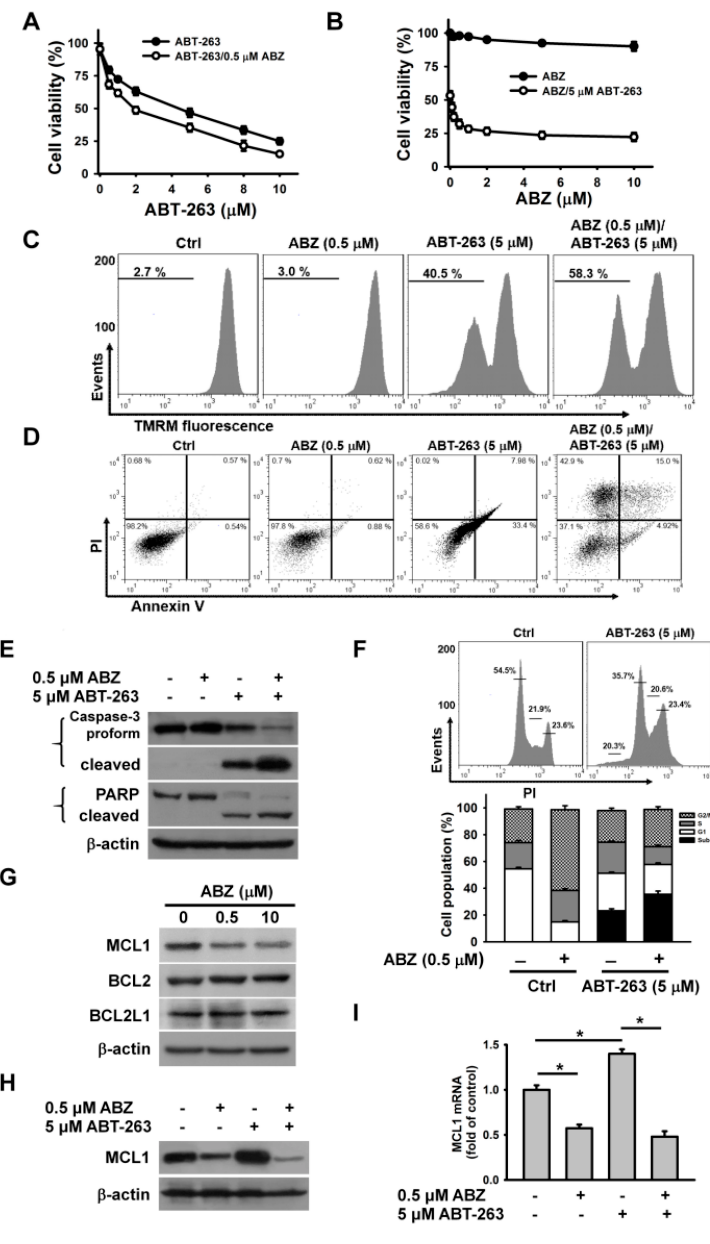
Figure 2. ABT-263 induced apoptosis of ABZ-treated K562 cells. Without specific indication, K562 cells were incubated with 0.5 μ M ABZ, 5 μ M ABT-263, or the combination of 0.5 μ M ABZ and 5 μ M ABT-263 for 24 h. ( A ) ABZ enhanced the cytotoxicity of ABT-263. K562 cells were incubated with 0.5 μ M ABZ and indicated ABT-263 concentrations for 24 h. ( B ) ABT-263 enhanced the cytotoxicity of ABZ. K562 cells were incubated with 5 μ M ABT-263 and indicated ABZ concentrations for 24 h. ( C ) Analysis of ΔΨ m in ABZ-, ABT-263-, and ABZ/ABT-263-treated K562 cells. Moreover, ΔΨ m was analyzed by flow cytometry. ( D ) Annexin V-PI double staining of ABZ-, ABT-263-, and ABZ/ABT-263-treated K562 cells. ( E ) The cleavage of procaspase-3 and PARP in ABT-263- and ABZ/ABT-263-treated K562 cells. ( F ) Cell cycle analysis of ABZ-, ABT-263-, and ABZ/ABT-263-treated K562 cells. (Top panel) Cell cycle distribution of ABT-263-treated cells. (Bottom panel) Quantitative analyses of cell cycle distribution in K562 cells treated with ABZ, ABT-263, and ABZ/ABT-263. ( G ) Effect of ABZ on MCL1, BCL2, and BCL2L1 expression in K562 cells. K562 cells were treated with indicated ABZ concentrations for 24 h. ( H ) ABZ suppressed ABT-263-induced MCL1 upregulation. ( I ) ABZ suppressed ABT-263-induced increased MCL1 mRNA level. The level of MCL1 mRNA was analyzed by qPCR (mean ± SD, * P < 0.05).